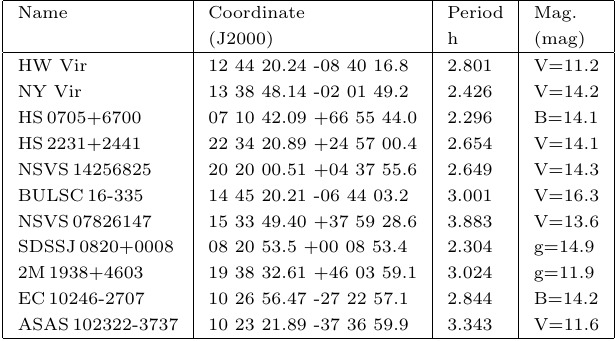
Table 1: Summary of our